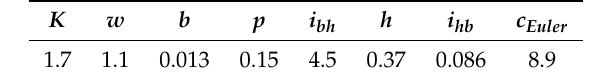
Table 3. Coefficients of Equation (4) determined by a least square adjustment [45].